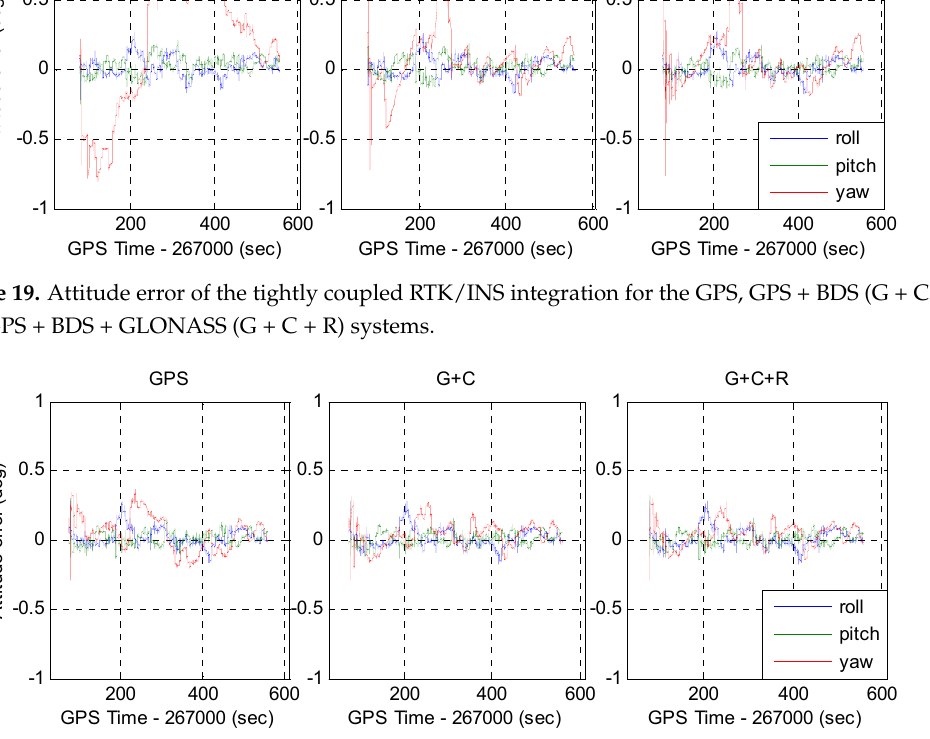
Figure 20. Attitude error of the tightly coupled RTK/INS/Vision integration for the GPS, GPS + BDS (G + C), and GPS + BDS + GLONASS (G + C + R) systems.